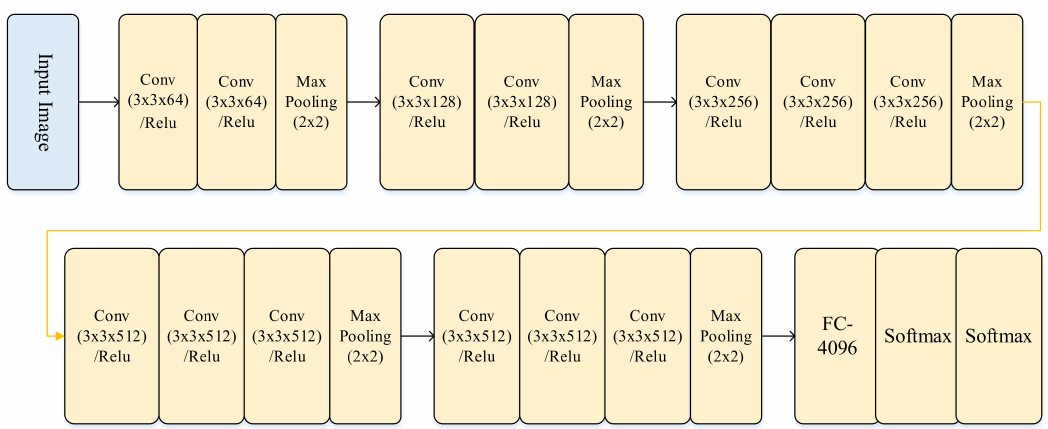
Figure 2. VGG16 network structure diagram.